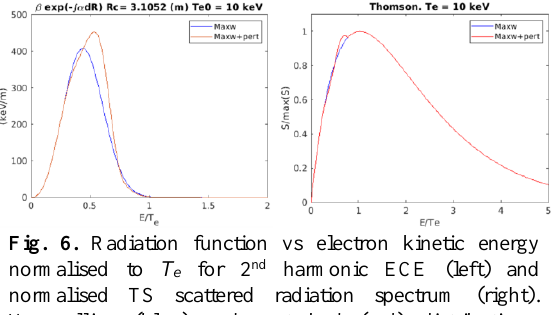
Fig. 6. Radiation function vs electron kinetic energy normalised to T e for 2 nd harmonic ECE (left) and normalised TS scattered radiation spectrum (right). Maxwellian (blue) and perturbed (red) distributions. Perturbation parameters: f 0 = 0.03, p 0 /p th = 1,  /p th = 0.25.